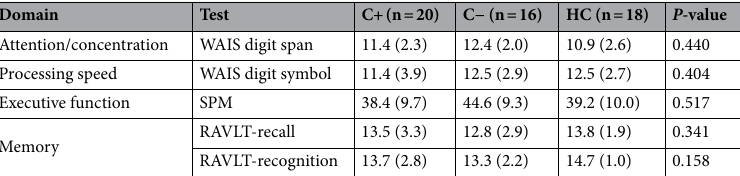
Table 2. Summary of neuropsychological assessments. Values are means (SD). Higher scores on WAIS Digit span, WAIS Digit symbol, SPM, and RAVLT indicate better performance. C + patients treated with chemotherapy, C− patients not treated with chemotherapy, HC healthy controls, RAVLT Rey-Kim auditory verbal learning test, SPM Raven’s standard progressive matrices, WAIS Wechsler adult intelligence scale.